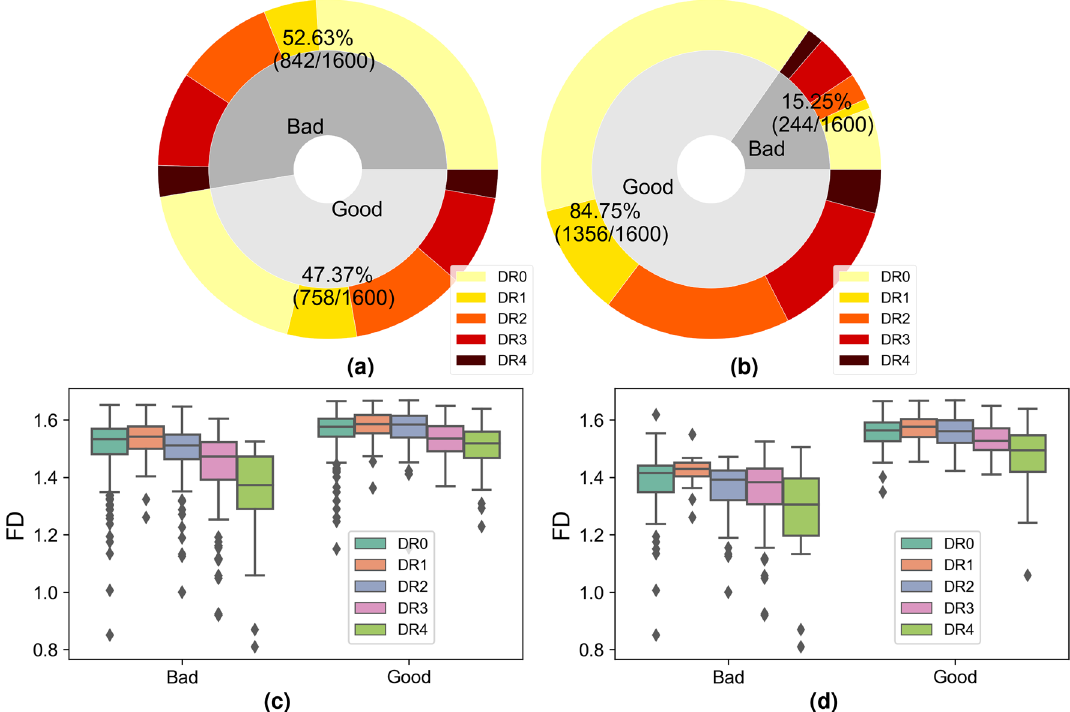
Figure 3. Top row: image distribution with respect to image quality and DR level in DeepDRiD. Pie plots of ( a ) original dataset and ( b ) label-revised dataset. For the severity of DR, a larger number refers to the higher risk of vision threatening. DR0 refers to normal and DR4 is the sight-threatening level. Bottom row: statistical results of FD in different image quality groups and DR levels. Box plots of ( c ) original and ( d ) label-revised datasets. In ( d ), there are some outlier points of good quality images in DR0 and DR4. They refer to images with decreased vessel density. In bad quality group of ( d ), outlier points with large FD values are observed and these images are labeled as low quality because of inadequate field definition. However, there are clear visibility of macular vessels in images resulting into unexpected high